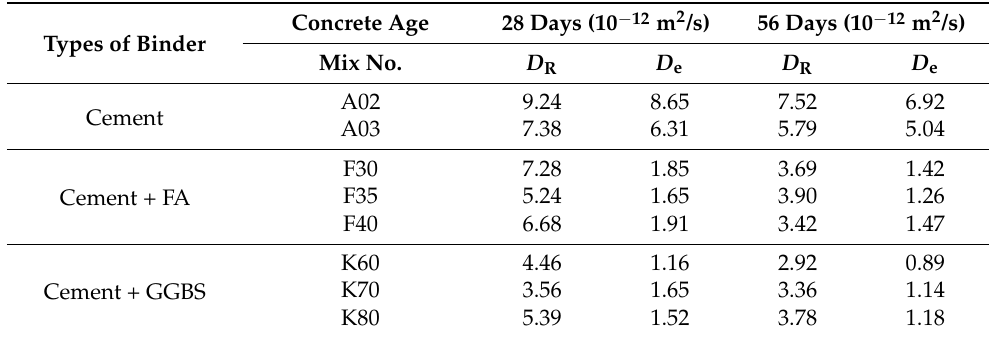
Table 7. Diffusion Coefficients are Calculated from Different Methods. Types of